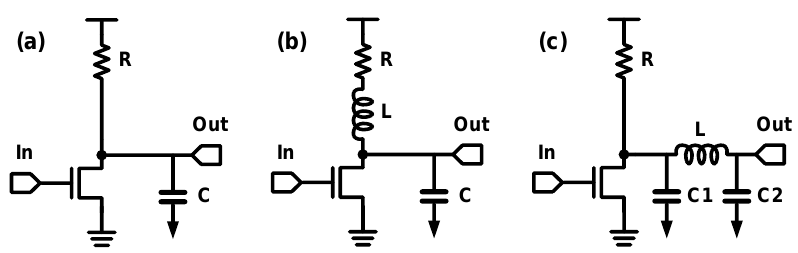
Figure 29. Circuit diagrams of ( a ) CS stage without inductive peaking, ( b ) CS stage with shunt peaking, ( c ) and CS stage with series peaking.